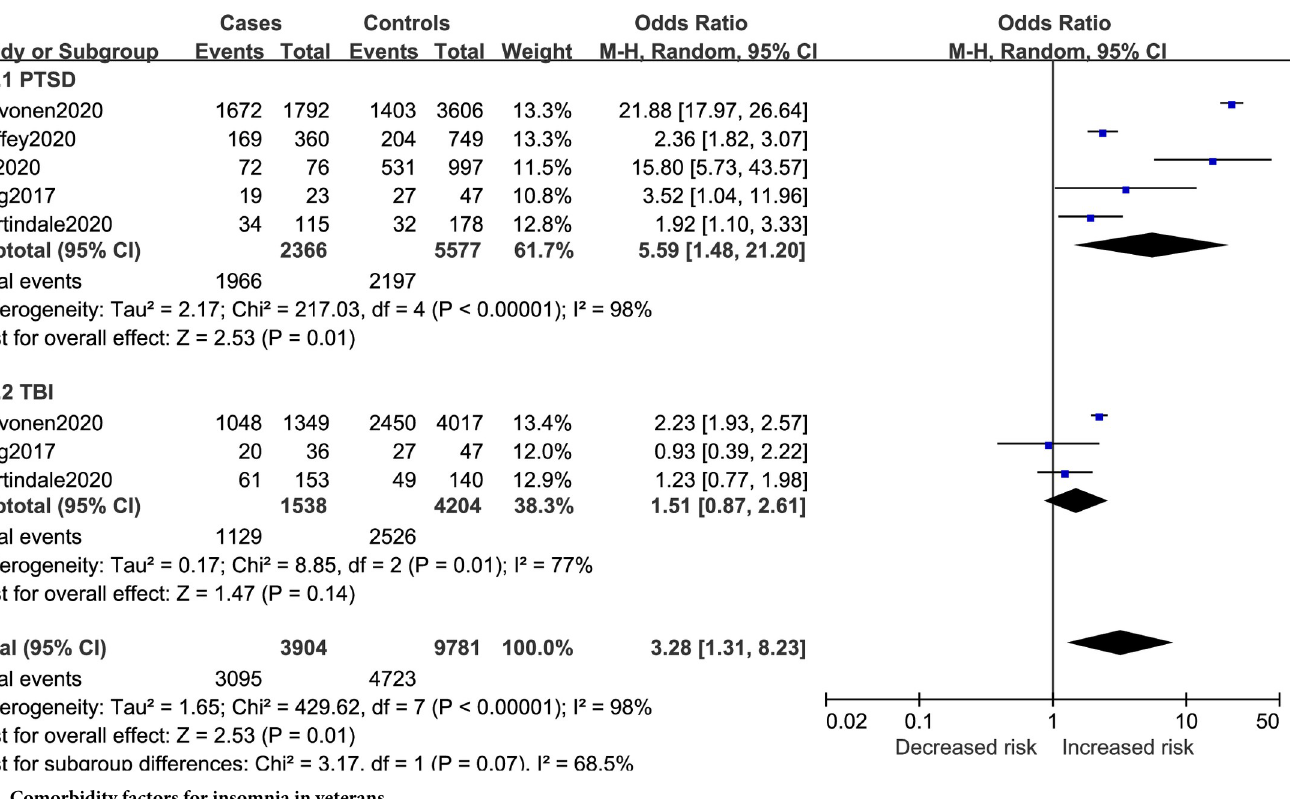
Fig 10. Comorbidity factors for insomnia in veterans.